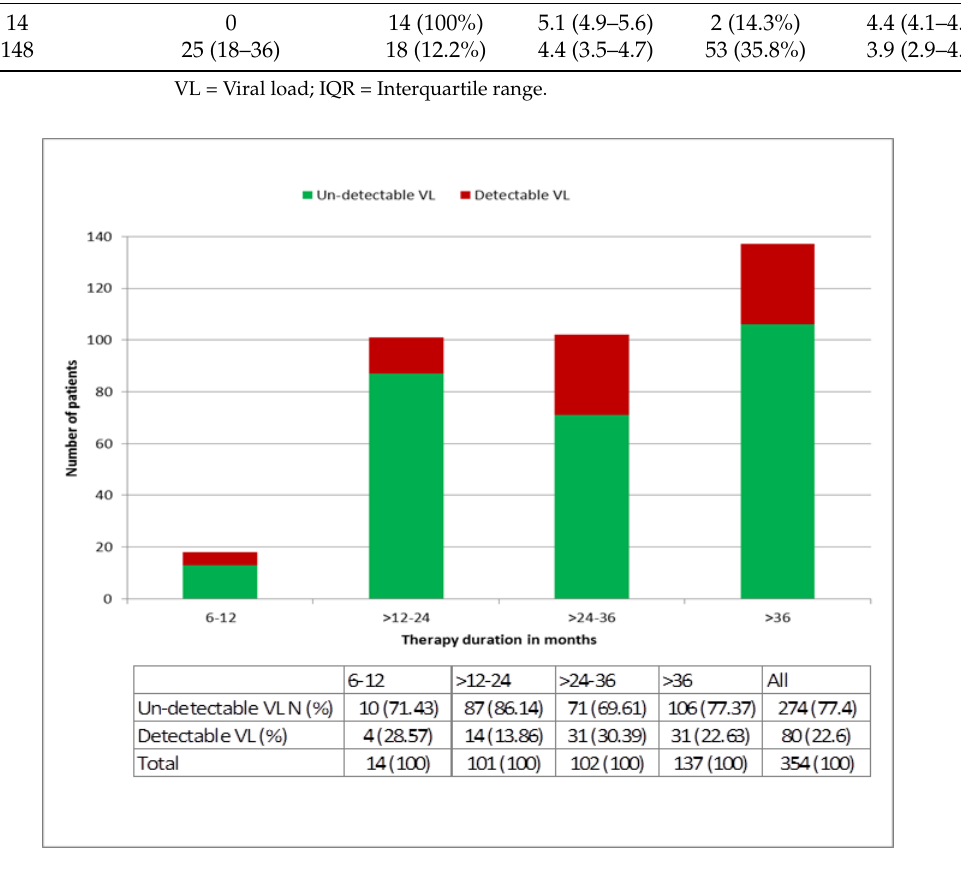
Figure 3. The proportion of patients with successful treatment (undetectable viral load) at different time intervals after the start of first-line treatment. (Undetectable viral load on therapy can be con- sidered successful treatment only for patients ≥ 6 months on therapy, EACS guidelines